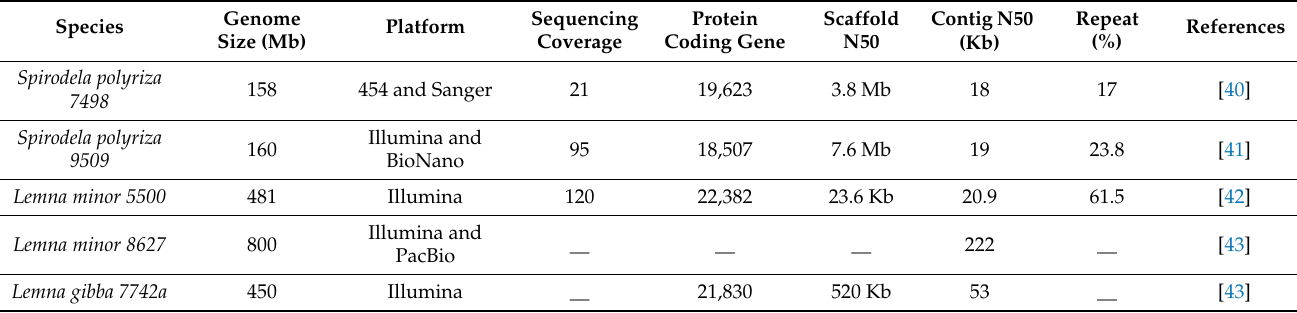
Table 2. Complete duckweed